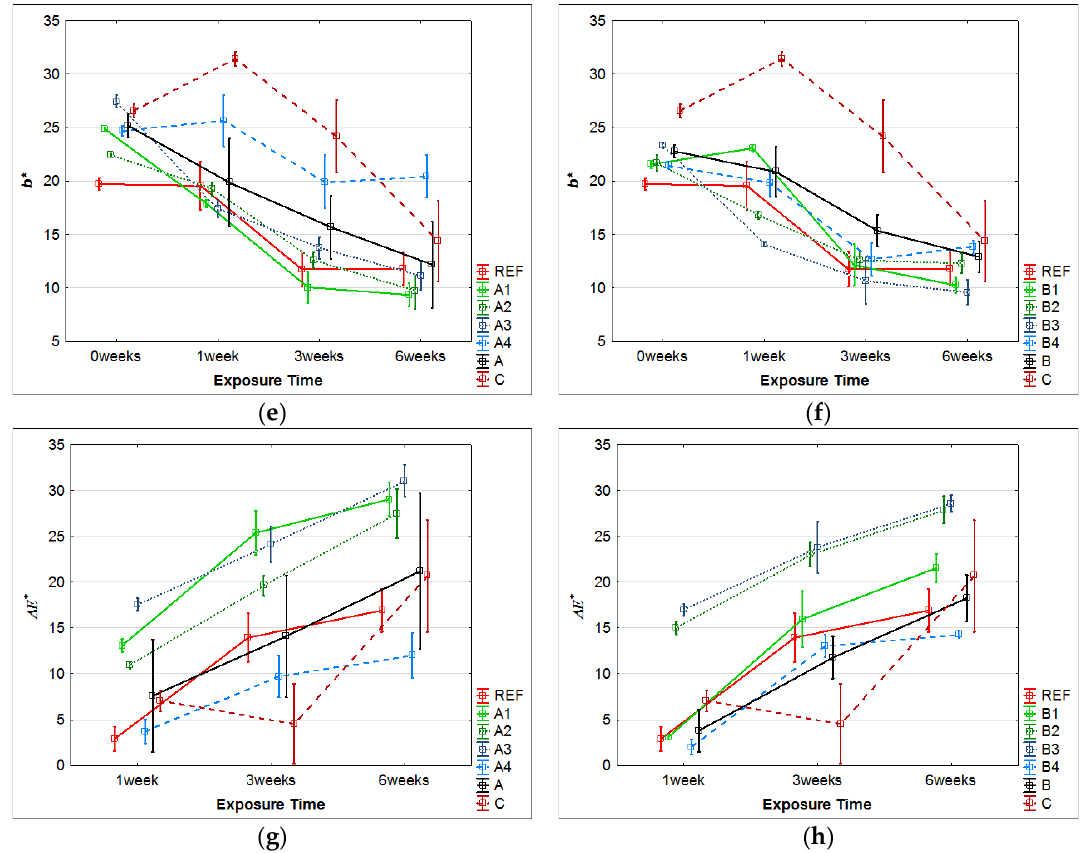
Figure 2. Colour changes to tested coatings during 6 weeks of artificial weathering. REF: native untreated oak wood; A: oak wood with the nano-based hydrophobic coating; B: oak wood with the hydrophobic coating with wax additives; 1, 2, 3, 4: the types of oak wood surface treatments; C: oil-based coating. ( a ) Increasing of L* values (lightness) of hydrophobic coating (A) with different surface treatments of oak wood (No. 1–4—see Tables 1 and 2); ( b ) Increasing of L* values (lightness) of hydrophobic coating (B) with different surface treatments of oak wood (No. 1–4); ( c ) Decreasing of a* values (red shades) of hydrophobic coating (A) with different surface treatments of oak wood (No. 1–4); ( d ) Decreasing of a* values (red shades) of hydrophobic coating (B) with different surface treatments of oak wood (No. 1–4); ( e ) Decreasing of b* values (yelow shades) of hydrophobic coating (A) with different surface treatments of oak wood (No. 1–4); ( f ) Decreasing of b* values (yelow shades) of hydrophobic coating (B) with different surface treatments of oak wood (No. 1–4); ( g ) Total colour changes ∆ E* of hydrophobic coating (A) with different surface treatments of oak wood (No. 1–4); ( h ) Total colour changes ∆ E* of hydrophobic coating (B) with different surface treatments of oak wood (No. 1–4). Comparison with untreated oak wood (REF—similar trends) and oil-based coating (C—initial higher increasing of a* and b* values and their final decreasing) is